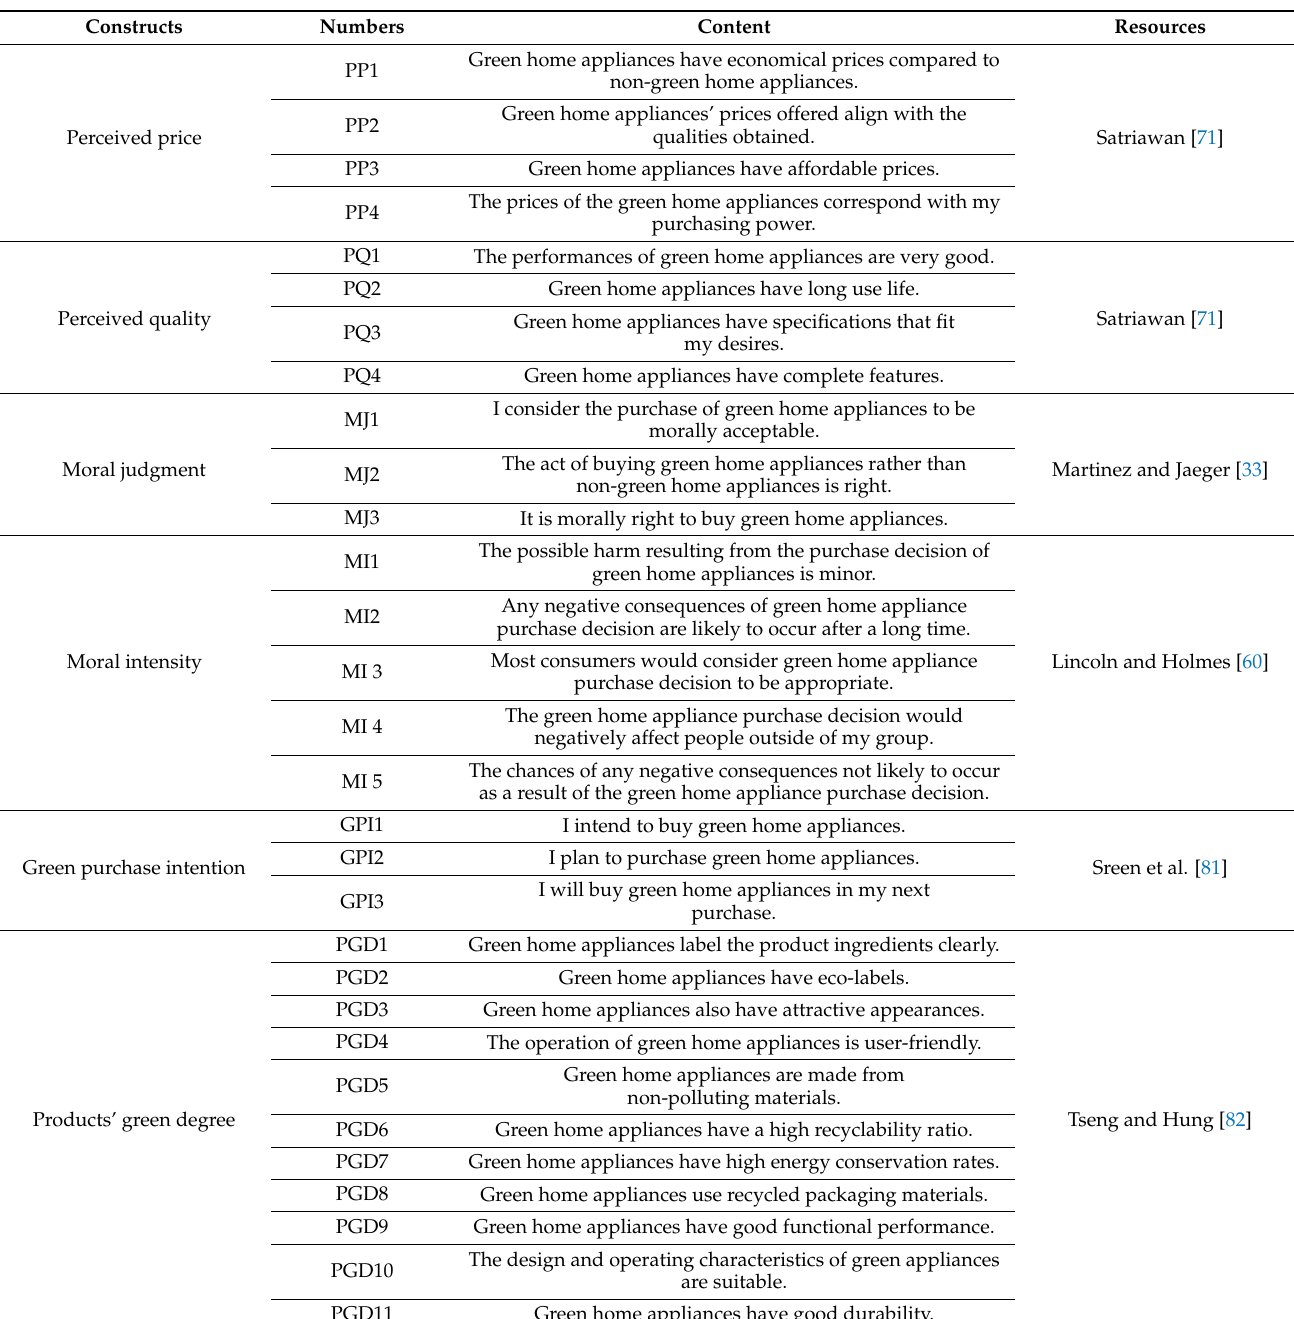
Table A1. Details of the